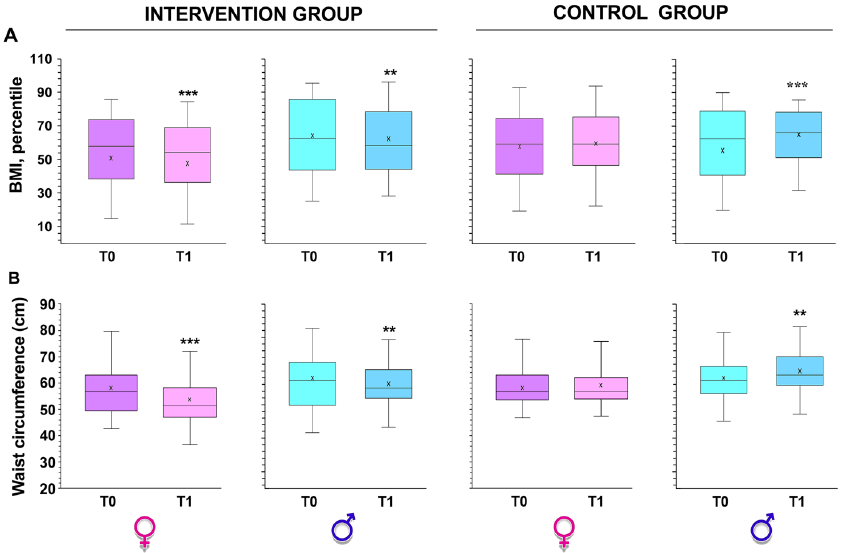
Figure 2. Differences in BMI and waist circumferences between the intervention ( A ) and control ( B ) groups obtained before (T0) and after (T1) intervention. ** p < 0.001 and *** p < 0.0001 by paired Student ’ s t test.